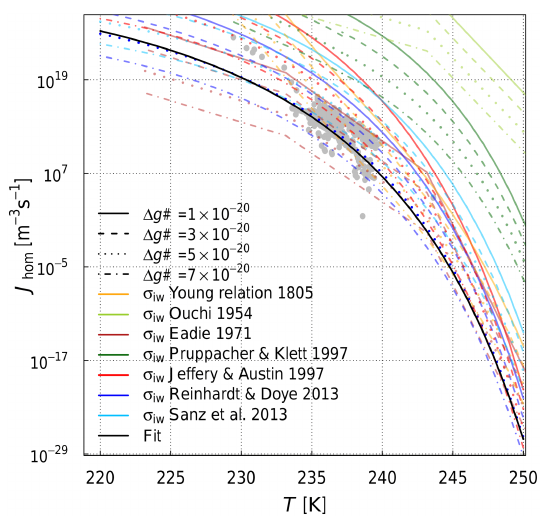
Figure 2. Comparison of the fitted J hom (T ) (solid black line) with calculated nucleation rates using different formulations of σ iw and constant values for (cid:49)g # . Grey dots show experimental homoge- neous freezing data. σ iw from Reinhardt and Doye (2013) captures the homogeneous freezing curve best.